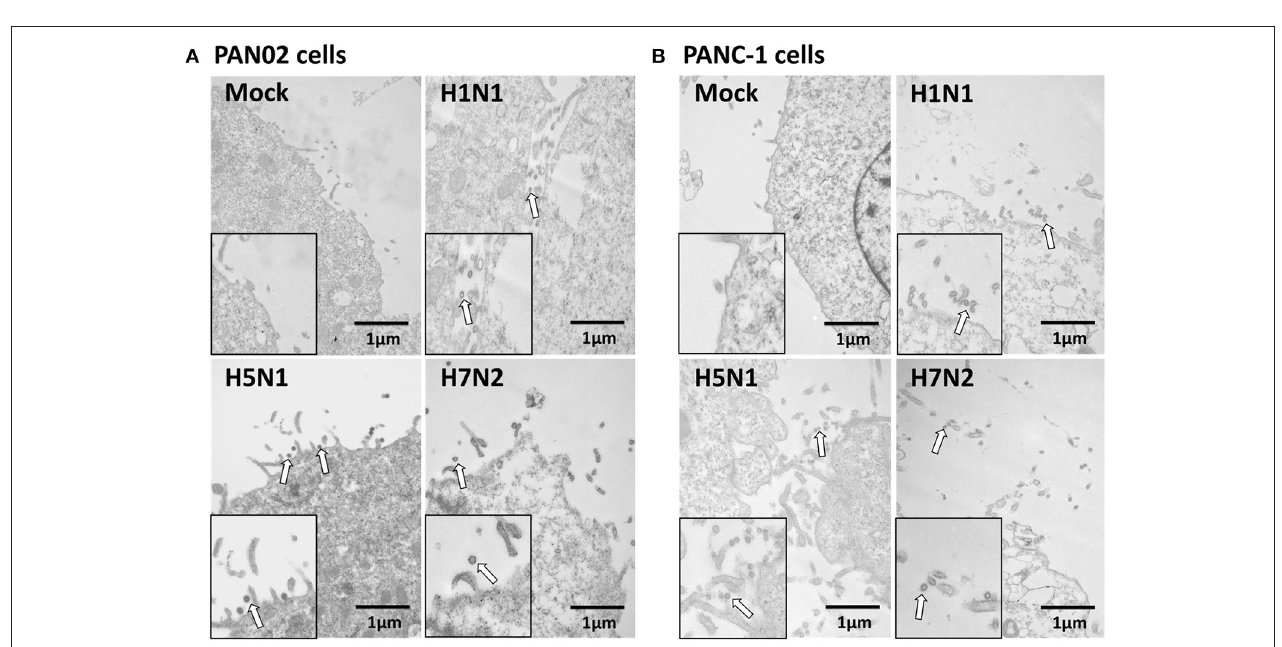
FIGURE 3 | Pancreatic cells release infectious virus following H5N1 IAV infection. (A) PAN02 and (B) PANC-1 cells were mock-treated or infected with three IAV subtypes at an MOI of 1 and transmission electron microscopy was used to observe the viruses released from the cell surface. Arrows denote the virus particles.